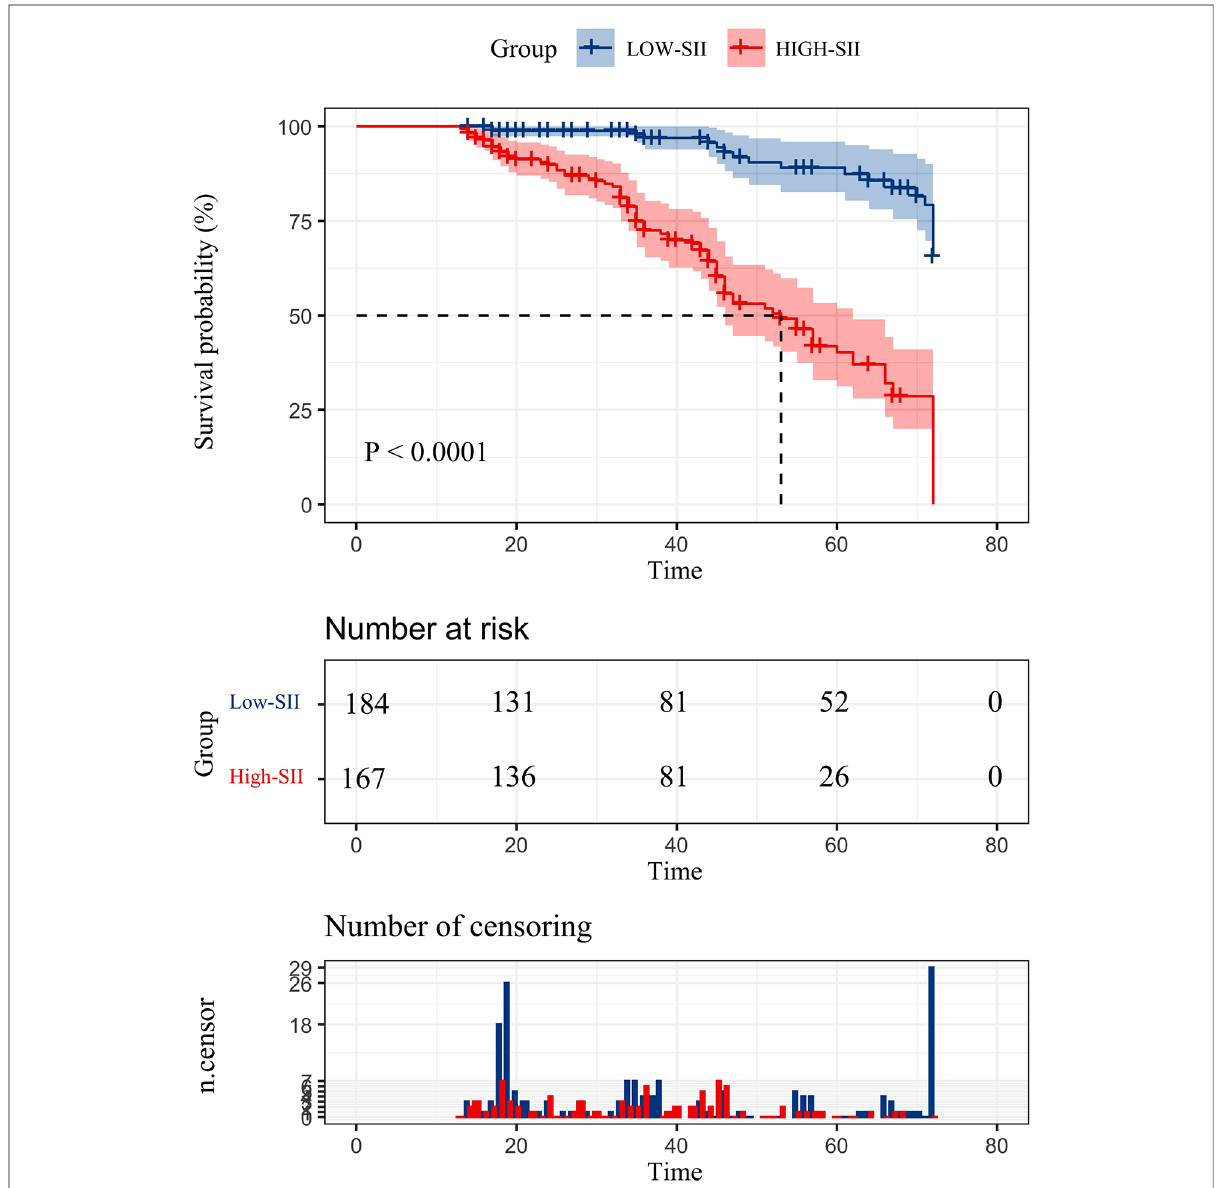
FIGURE 2 Postoperative overall survival curve of patients with hepatic alveolar hydatid disease in two